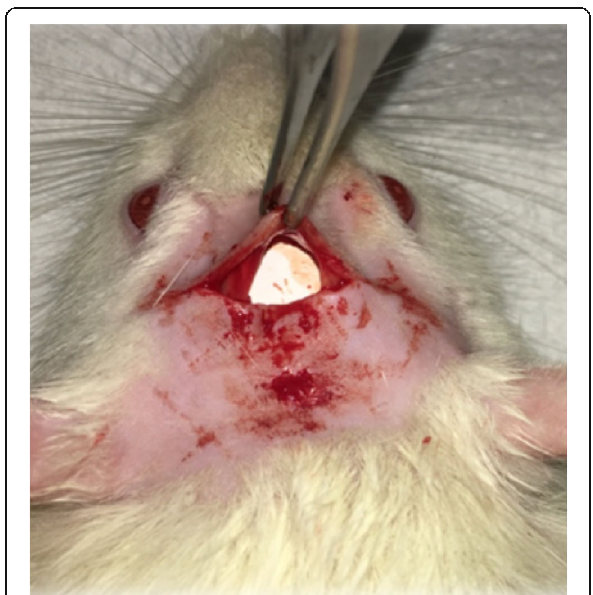
Fig. 1 Intraoperative photograph. Intraoperative photograph showing the implant material adapted to the calvarium before suturing. The rat ’ s head was shaved and disinfected prior to making an incision. A 2-cm-long transverse incision was made on the rat ’ s calvarium. Then, the implant was placed subperiosteally over the